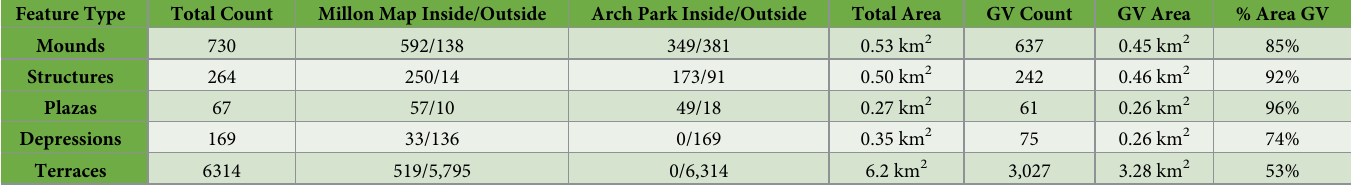
Table 1. Summary of features recognized on the lidar map and later ground-verified (GV) (count, surface area, and percentage). Feature Type Total